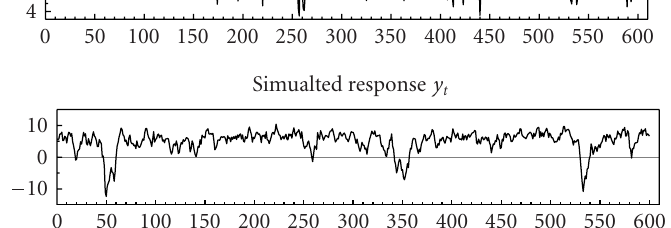
price index before and after the competitor are 0 . 0169 and − 0 . 0114. In this way, it seems that the studied store regained its price sensitive